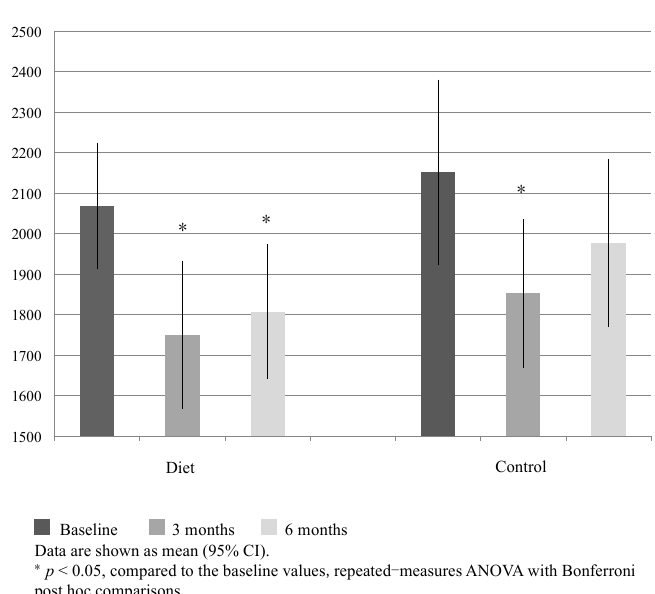
6 months Data are shown as mean (95% CI). * p < 0.05, compared to the baseline values , repeated - measures ANOVA with Bonferroni post hoc comparisons. Figure 2. Daily calorie intake by three-day diet diary at baseline vs. three and six months. Figure 2. Daily calorie intake by three ‐ day diet diary at baseline vs. three and six months.